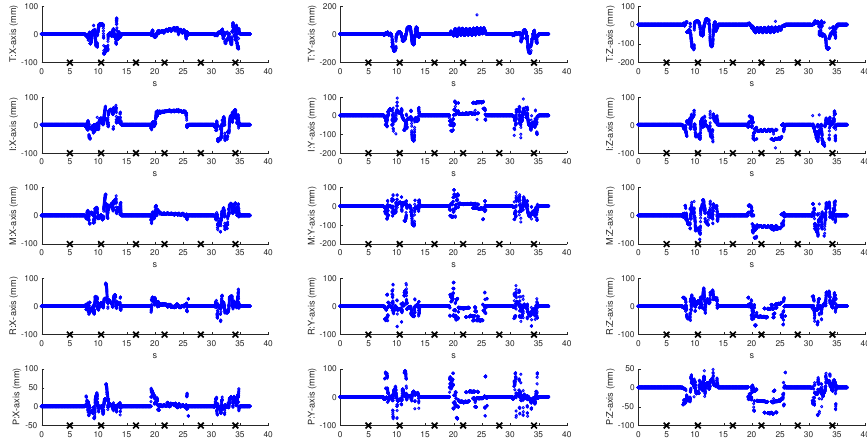
Figure 8. Differences between VG tracking measurements and horizontal LEAP measurements for each finger (T: thumb; I: index; M: middle; R: ring finger; and P: pinkie) and for each axis.